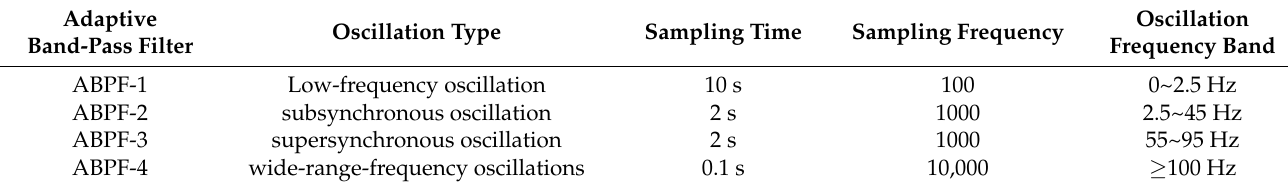
Table 1. Table showing the external parameter settings of ABPF for each frequency